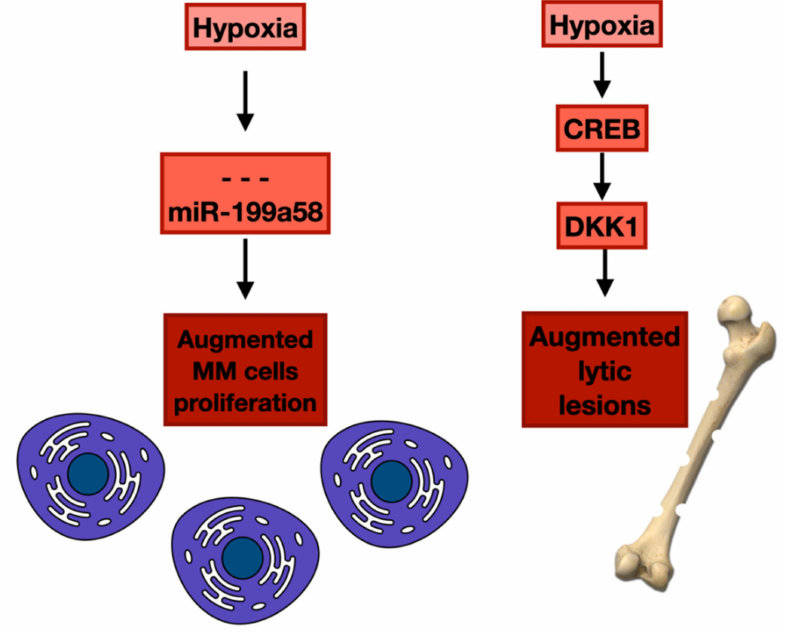
Figure 4. Hypoxia’s influence on MM cells’ proliferation and lytic lesions